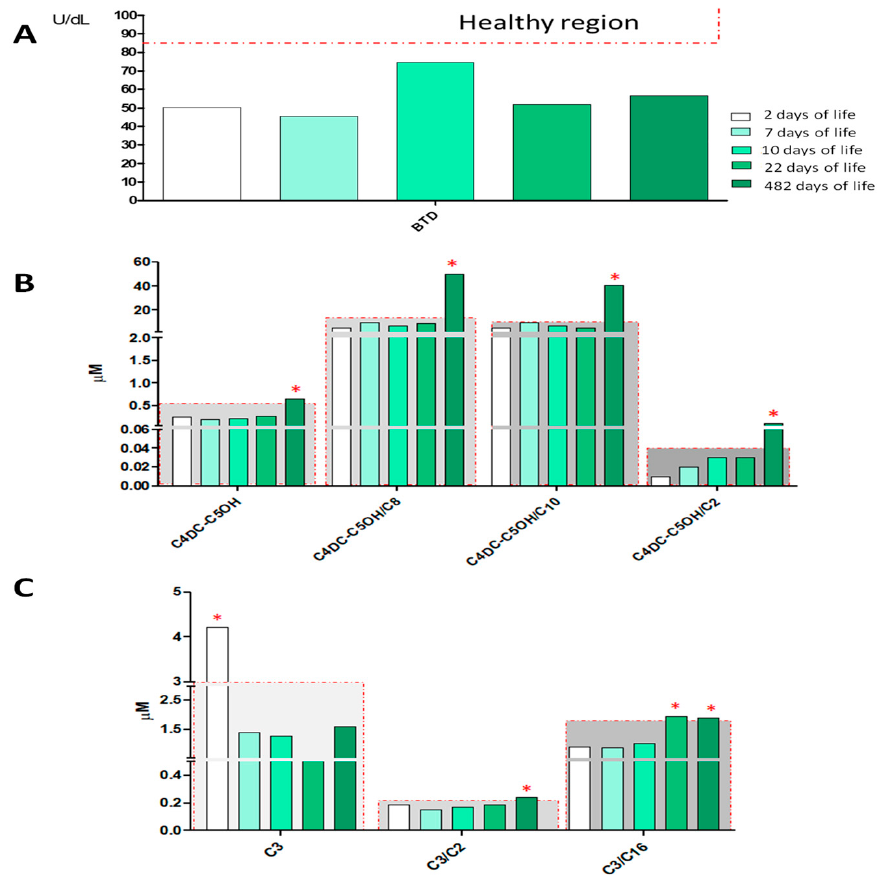
Figure 2. Histograms in the figure show the levels of BTD activity (Panel A ), C4DC-C5OH (methylmalonyl-3-hyroxy-isovalerylcarnitine) and its ratios C4DC-C5OH/C2, C4DC-C5OH/C10, C4DC-C5OH/C16 (Panel B ), and the level of C3, C3/C2, C3/C16 (Panel C) of the NBS analyses at 2, 7, 10, 22, and 482 days of life. The samples inside the gray region are considered within the reference limits, while samples falling outside the gray region and marked with red asterisks are outside of the reference limits for newborn